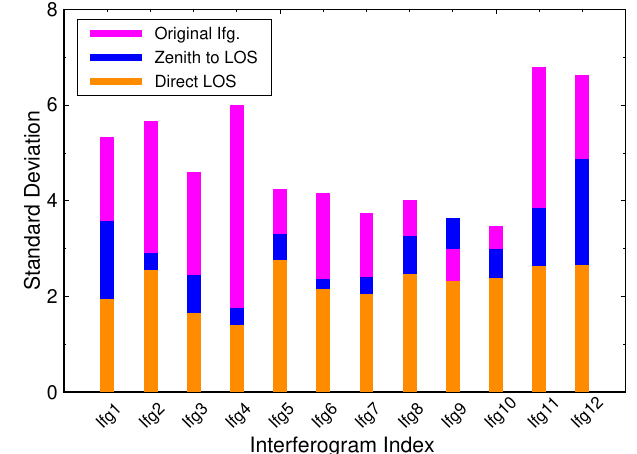
Figure 10. SD comparison of original interferograms (magenta bars), residual phases corrected from the Z-LOS method (blue bars), and residual phases after D-LOS correction (orange bars) on all twelve pairs in